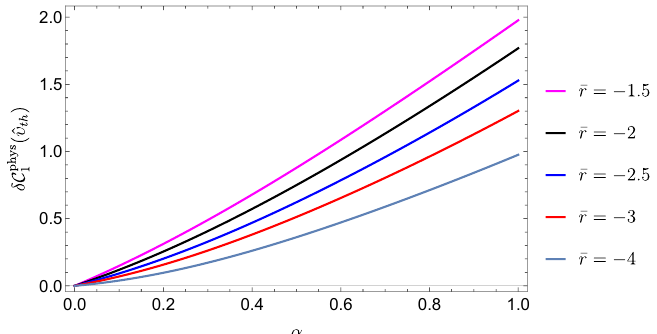
Figure 25 . The quantity (cid:14) C phys function of (cid:11) . We (cid:12)nd that the quantity (cid:14) C phys